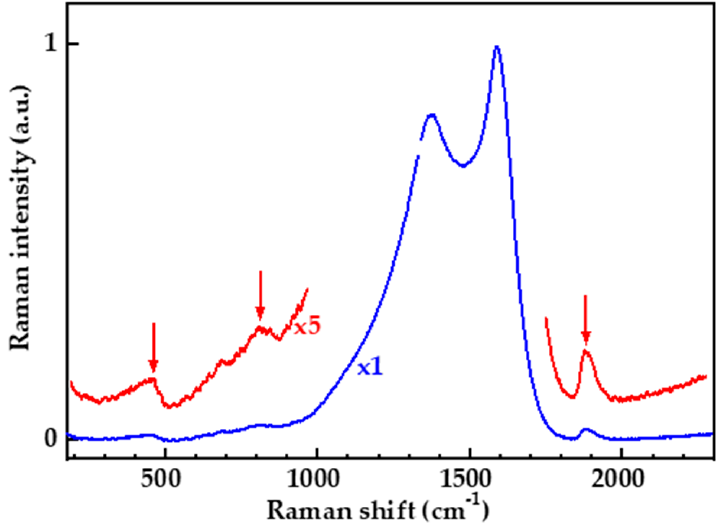
Figure 8. Raman spectrum of graphitized structure obtained at a laser fluence 20 J/cm 2 (blue line), and the fragments of the same spectrum, multiplied five times (red line). The arrows indicate the bands at 455, 810, and 1890 cm –1 .